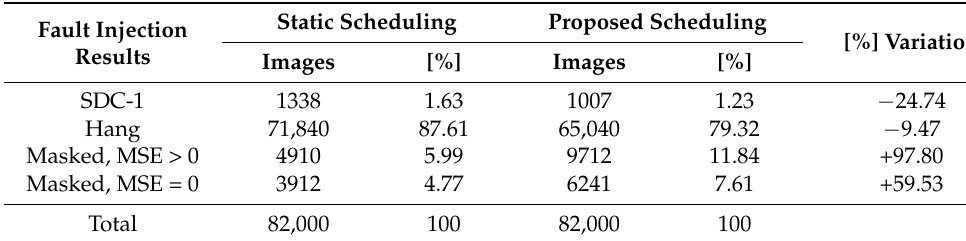
Table 4. RTL fault injection results: Evaluation of the effects of the same permanent faults on a CNN compiled with two different scheduling